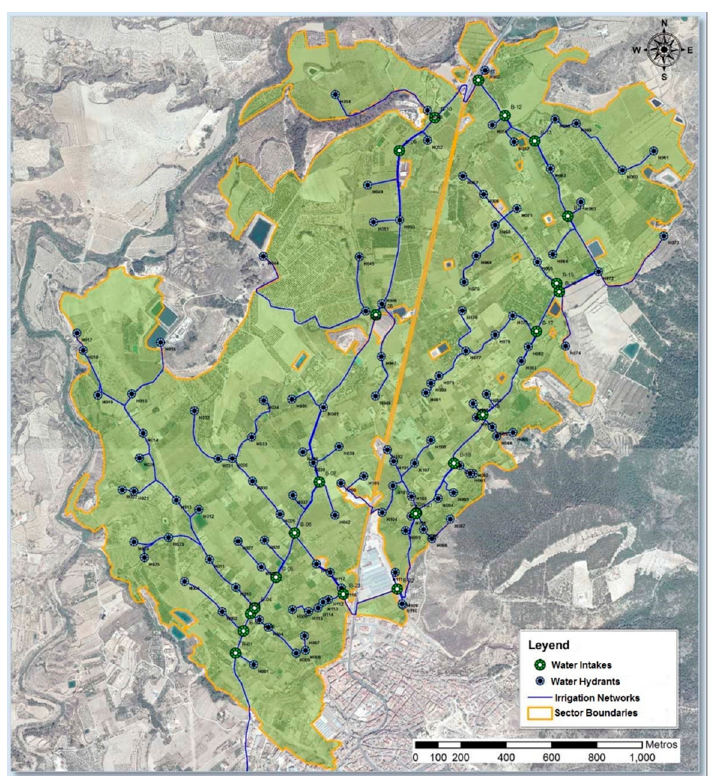
Figure 1. Irrigated area of the study zone of the water user’s association (WUA). (Source: Segura’s Hydrographic Confederation).